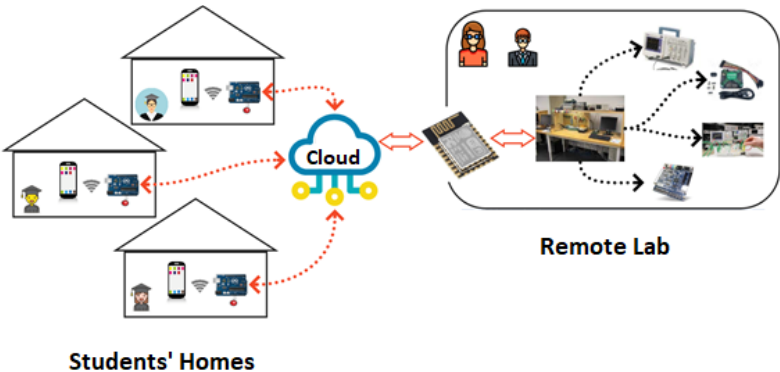
Figure 3. HomeLab integration via a remote